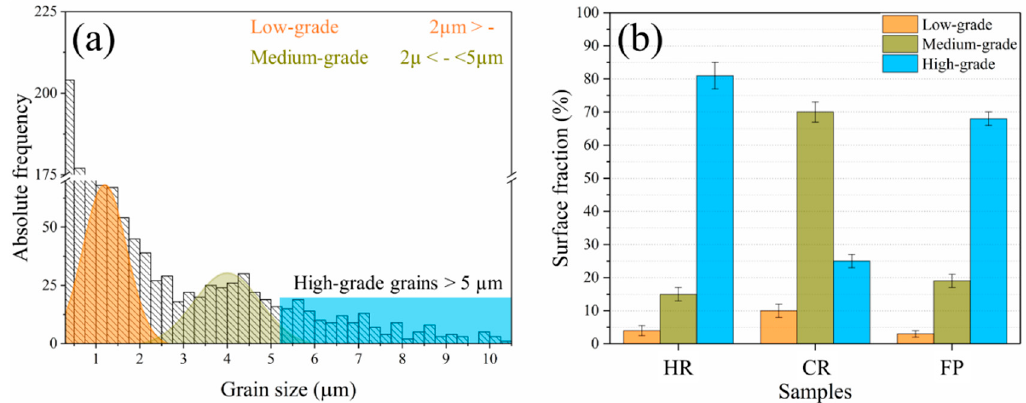
Figure 4. ( a ) Grain size histogram for HR sample, with 250 nm of bin size, computed from at least 2000 counted grains. ( b ) Surface fraction occupied by grains with different size ranges for all the studied samples.